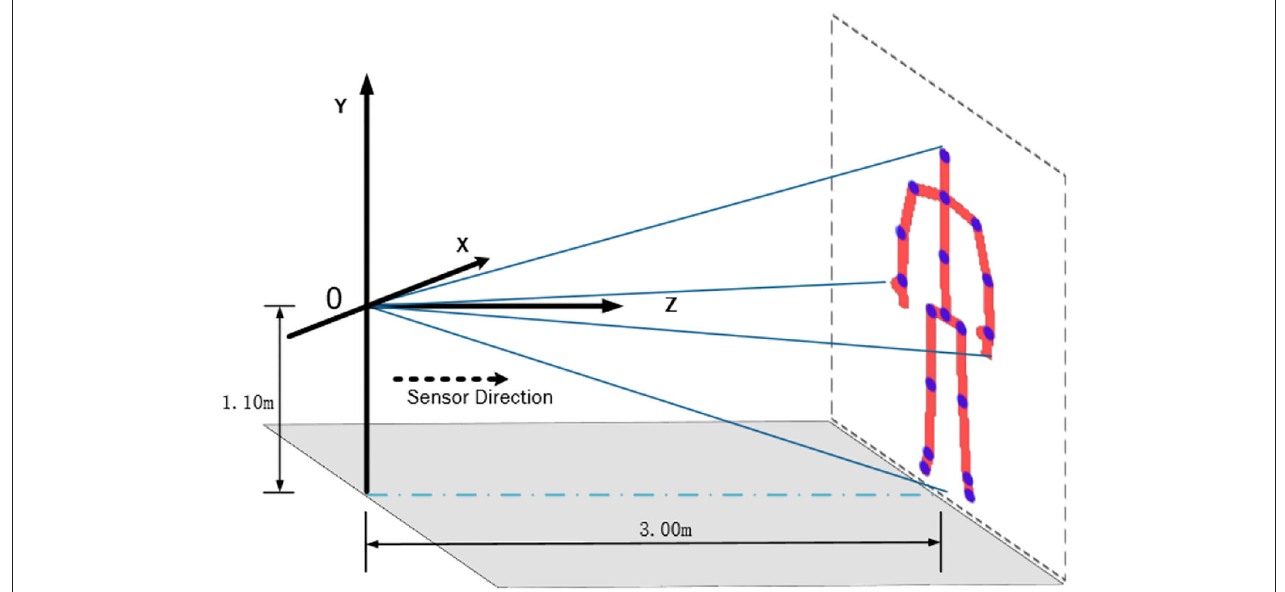
FIGURE 1 | Illustration of an experiment site. According to the basic parameters of Kinect, it is the best layout to fully catch the participants that Kinect was installed on a bracket 1.1 m above the ground, which was standing 3 m in front of the equipment and facing the Kinect.